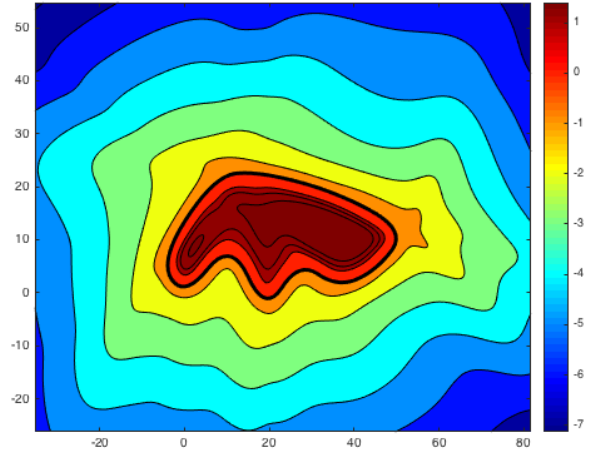
Figure 13. Algebraic level sets from a closed quadratic NURBS